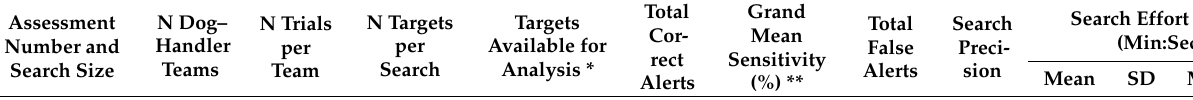
Table 2. Combined results for standard room searches, taken from Rutter et al. [12], Simple Field Condition (SFC) baseline searches, SFC post-training search assessments, Complex Field Condition (CFC) baseline searches (Experiment 2) and CFC post-training searches (Experiment 2). Sensitivity refers to proportion of targets found relative to the total number of targets, precision refers to the proportion of alerts directed towards a true target and search effort refers to search duration per search